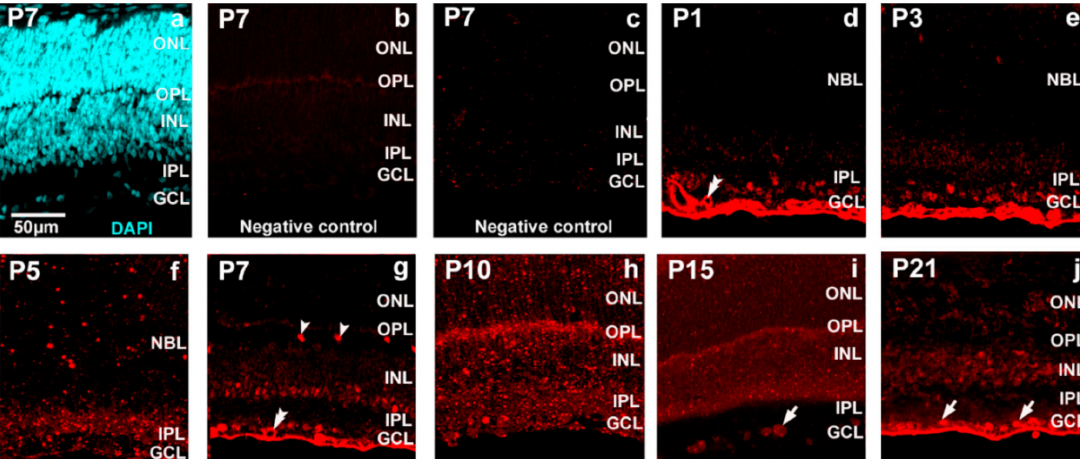
Figure 3. The cellular localization of miR-23 in the Wistar rat retina at the first 3 postnatal weeks by in situ hybridization (( d ) P1; ( e ) P3; ( f ) P5; ( g ) P7; ( h ) P10; ( i ) P15; ( j ) P21). The retina has been counterstained with DAPI ( a ) and controls ( b ) without anti-miR-23, ( c ) without anti-DIG-HRP are presented. Arrowheads indicate horizontal cells, double arrowheads indicate capillary and cells in the GCL are indicated with arrows. The scale bar represents 50 µ m. GCL—ganglion cell layer; IPL—inner plexiform layer; NBL—neuroblast layer; INL—inner nuclear layer; OPL—outer plexiform layer; ONL—outer nuclear layer.